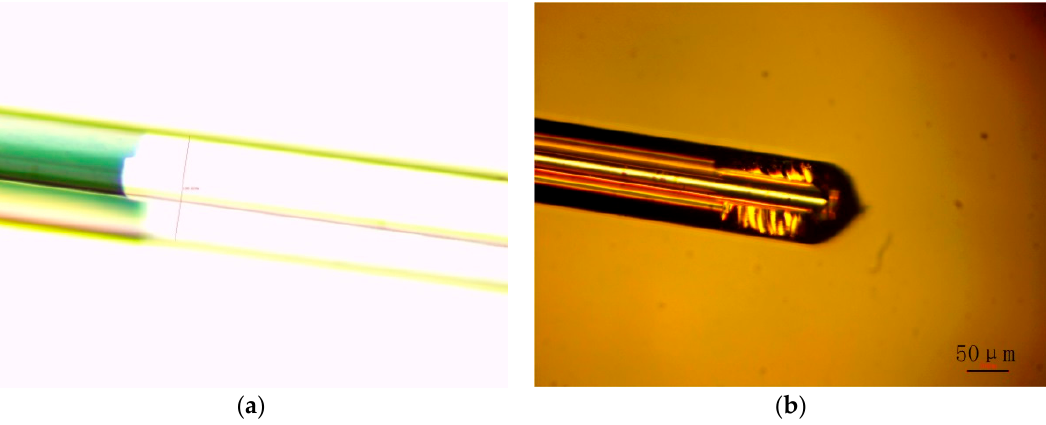
Figure 7. Microscopic observation of PCF. ( a ) Transmitted light image; ( b ) Reflected light image.